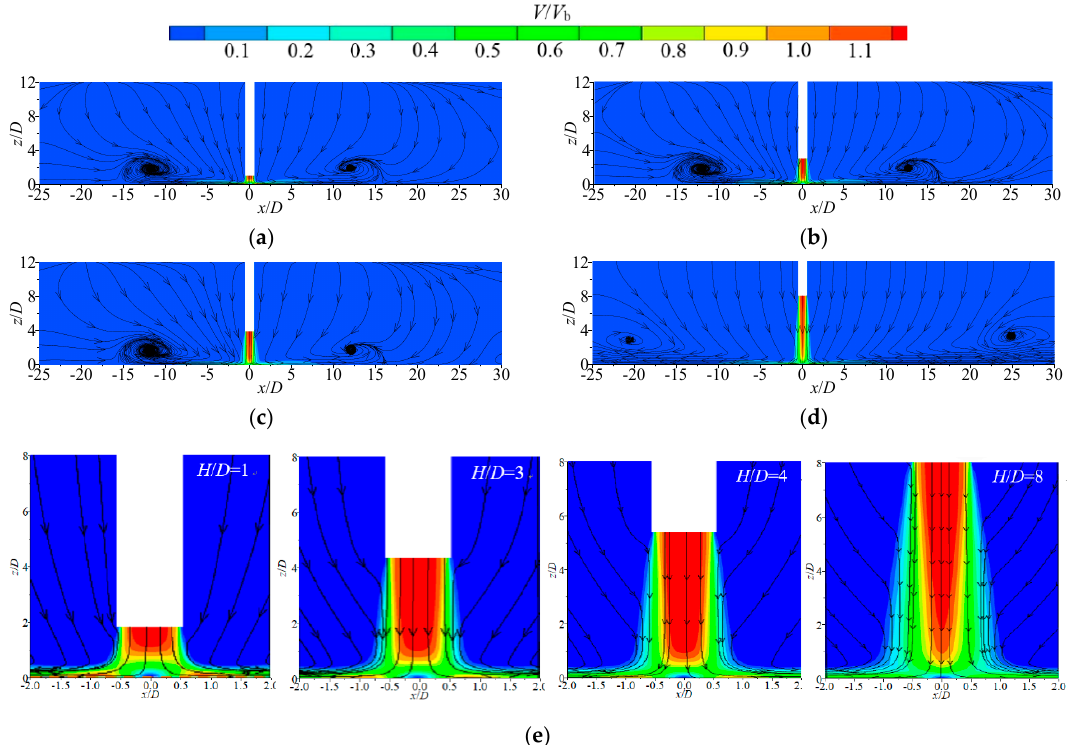
Figure 5. Normalized mean velocity V / V b contour and streamline of mid-section on submerged impinging jet at various impinging heights:( a ) H / D = 1; ( b ) H / D = 3; ( c ) H / D = 4; ( d ) H / D = 8; ( e ) enlarged view on the impinging region.